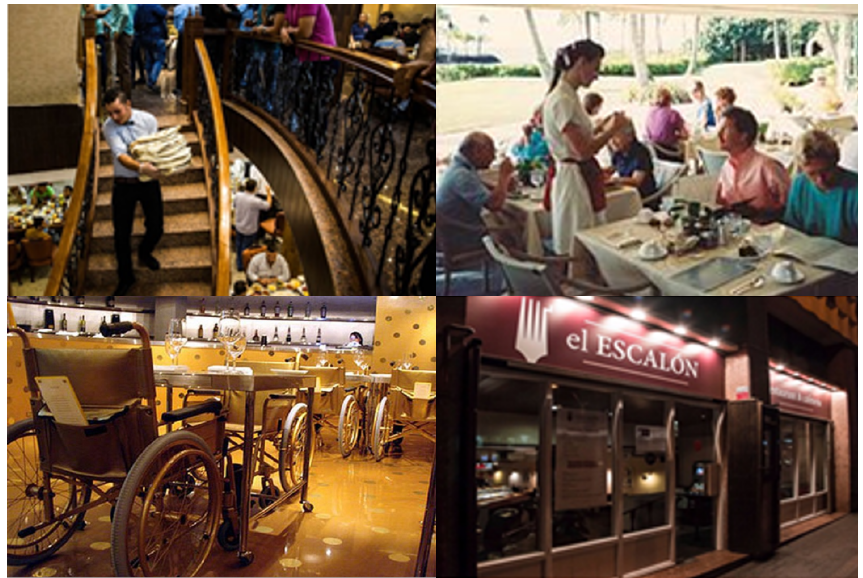
Figure 8. Different and possible scenarios within a restaurant in which a waiter robot should be able to manage. From left to right and from top to bottom, there are some architectural obstacles such as stairs, an area of tables, other waiters and guests, ramps and entrance or exit